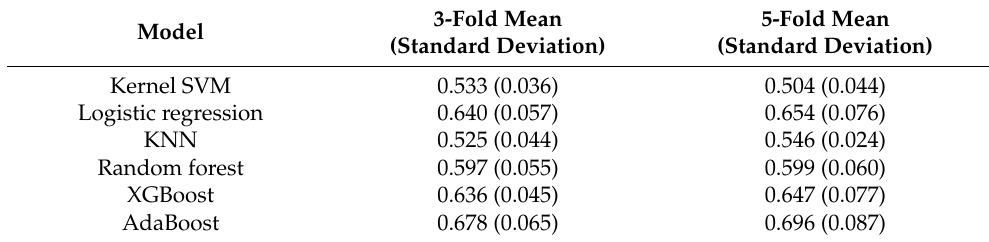
Table 3. Cross-validation AUROC values of ML